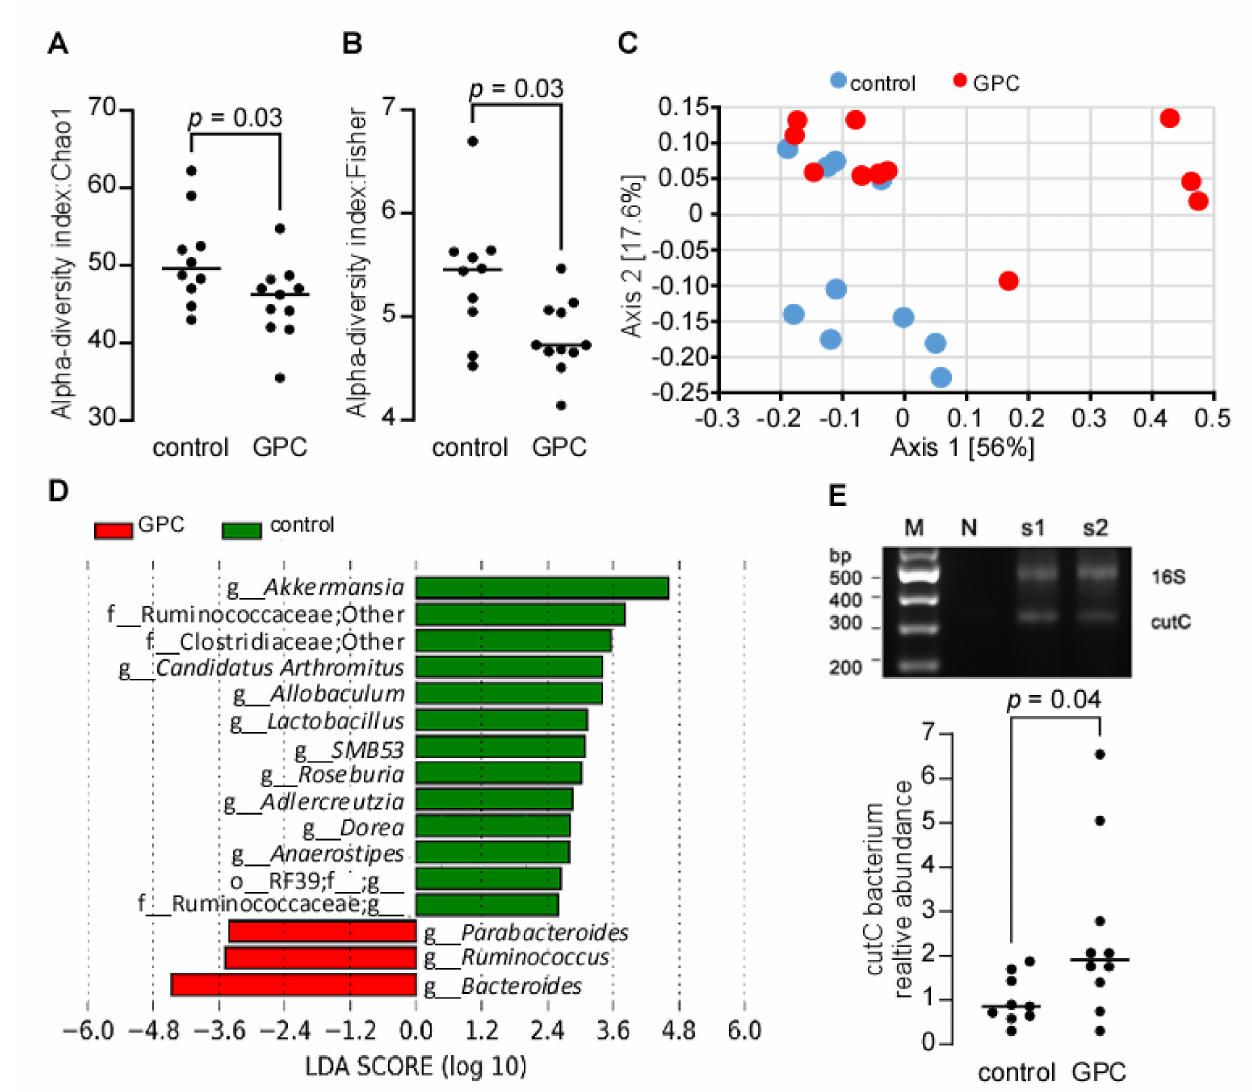
Figure 8. GPC supplementation shifts the gut microbial community. ( A , B ) alpha-diversity: Chao1 ( A ) and Fisher index ( B ) of gut microbiota community structure in female C57BL/6J Apoe − / − mice after 16 weeks on GPC supplemented ( n = 11) or control chow diet ( n = 10). Cecal DNA was extracted for 16S rRNA gene sequencing. ( C ) Principal coordinates analysis of weighted UniFrac distances of microbial community with proportion of variance explained by each principal coordinate axis denoted in each axis label. ( D ) LEfSe identified cecal microbial taxa enriched in GPC-fed mice vs. control chow diet-fed mice ( p < 0.05 by the Kruskal–Wallis test, log 10 (LDA score) > 2). ( E ) RT-PCR quantitation of choline TMA lyase C subunit (CutC) encoding bacterium relative abundance in female C57BL/6J Apoe − / − mice fed either GPC supplemented chow or control chow diet. The relative abundance of CutC-containing bacteria was normalized to that of control chow diet feeding mice. The top panel in ( E ) is the confirmation of specificity for CutC and 16S rRNA gene PCR products from two typical samples by 2% agarose gel electrophoresis with no DNA template as negative control (N) and 100 bp DNA ladder as marker (M). p values were calculated by Wilcoxon rank sum